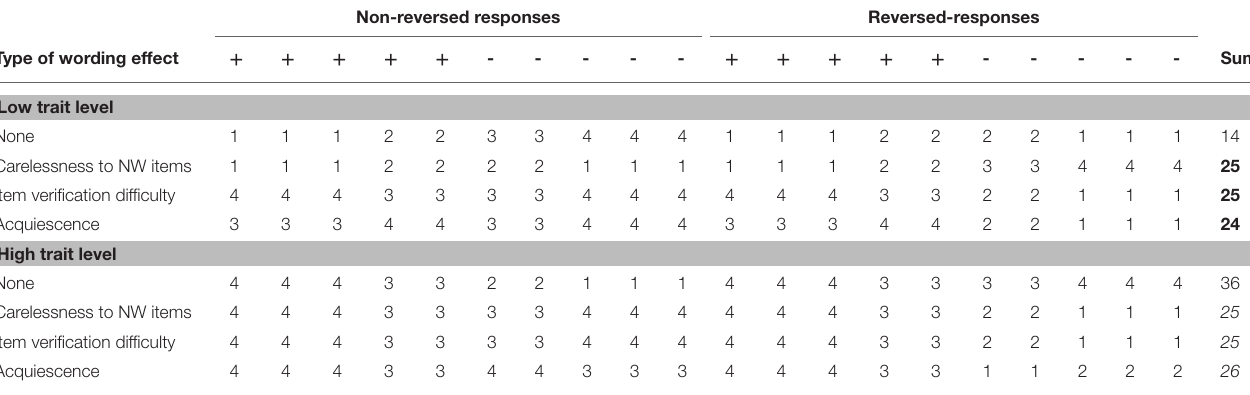
TABLE 1 | Examples of response patterns for the wording effects of carelessness, item verification difficulty, and acquiescence. Non-reversed